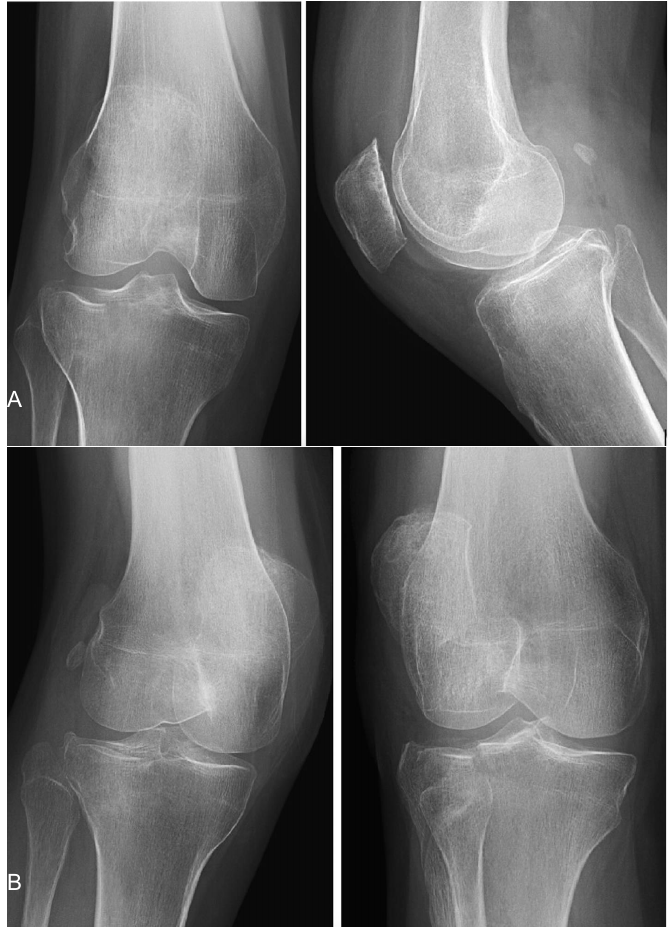
Figure 2. (A) Orthogonal radiographs (two-view) of one “critical miss” that was initially recommended to be best managed with nonoperative treatment but then later was recommended for operative management with the addition of oblique radiographs. Seen to have a lateral tibial plateau fracture. (B) Oblique radiographs (four-view component) of one “critical miss” that was initially recommended to be best managed with nonoperative treatment but then later recommended for operative management with the addition of oblique radiographs. Seen to have a lateral tibial plateau